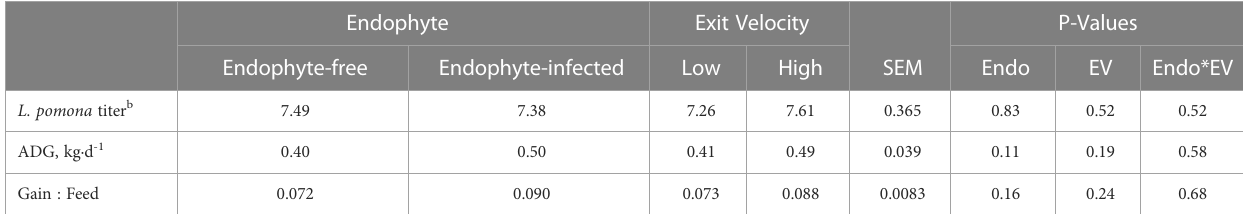
TABLE 7 Experiment 2 Leptospirosis pomona titer, average daily gain (ADG), and gain:feed ratio responses to endophyte (Endo) and exit velocity (EV) treatments a